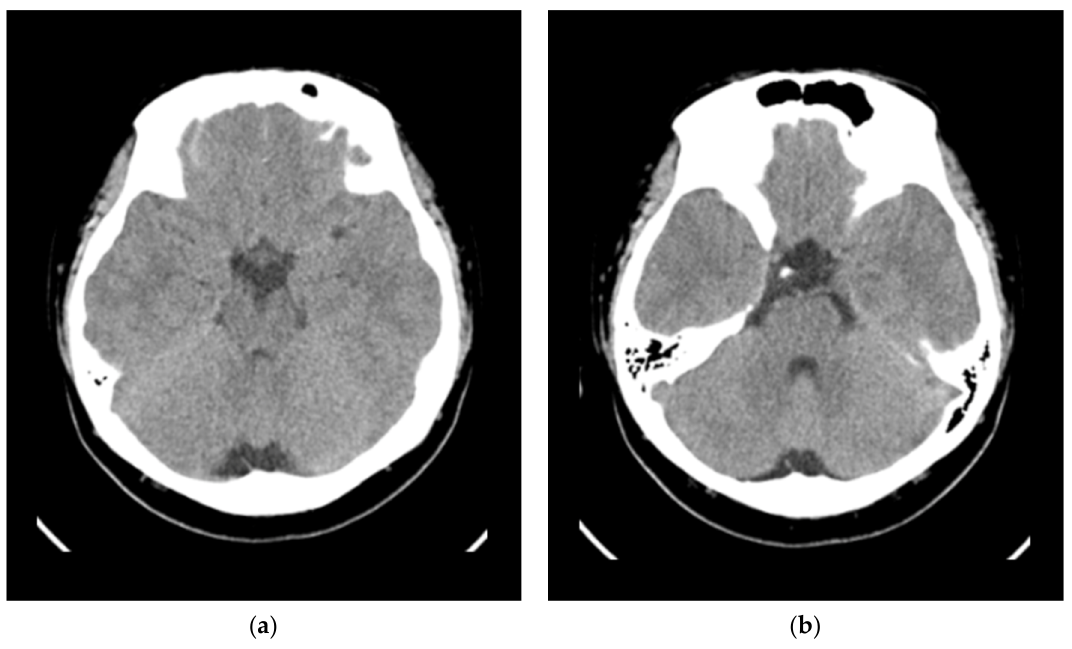
Figure 2. Two different cuts of brain CT revealed no space-occupying lesions, no cerebral edema and no intracranial hemorrhage. ( a ) Level of the midbrain. ( b ) Level of the pons. After initial multidisciplinary consultations, adrenal crisis was the primary diagno- sis, with differential diagnosis including acute encephalitis of COVID-19, multi-system inflammatory syndrome in children (MIS-C), and concomitant herpetic encephalitis. An immediate dose of 100 mg of hydrocortisone was loaded intravenously in the ED, fol- lowed by 50 mg every six hours (100 mg/m 2 /day). Intravenous acyclovir was also given empirically. The patient was admitted to the Intensive Care Unit for close observation. After a multidisciplinary discussion, a 3-day-course of Remdesivir, 200 mg on the first day and 100 mg on the next two days, was administered. His consciousness and mental status returned normal at 4 h after administration of hydrocortisone. Acyclovir was discontin- ued because of the rapid response to hydrocortisone and the very low likelihood of herpes simplex virus infection. We gradually tapered the hydrocortisone dose and changed to oral cortisone acetate at the previous physiological dose. The patient was discharged with no neurological sequelae on the fifth day after diagnosis of COVID-19. 3. Discussion 3.1. COVID-19 in Children with Cancer and Brain Tumor Our case is an adolescent brain tumor survivor who experienced adrenal insuffi- ciency related to acute COVID-19 infection. Most of the children with malignancies have a mild disease of COVID-19 [9,10]. However, pediatric oncology patients are prone to suf- fer from worse clinical conditions and more likely to require ICU support when compared to non-oncology patients [11]. Among brain tumors, unlike other oncology diseases, there seems to be no significant difference in mortality from COVID-19. It may be explained by less myelosuppressive brain tumor therapy [12]. Rossella et al. reported a 9-year-old girl with suprasellar non-germinomatous germ cell tumor and hypothalamic-pituitary failure. She was accidently found to be infected with COVID-19 when screened before admission for autologous stem-cell transplantation (ASCT). She was asymptomatic during the course, and she received ASCT one month later [13].